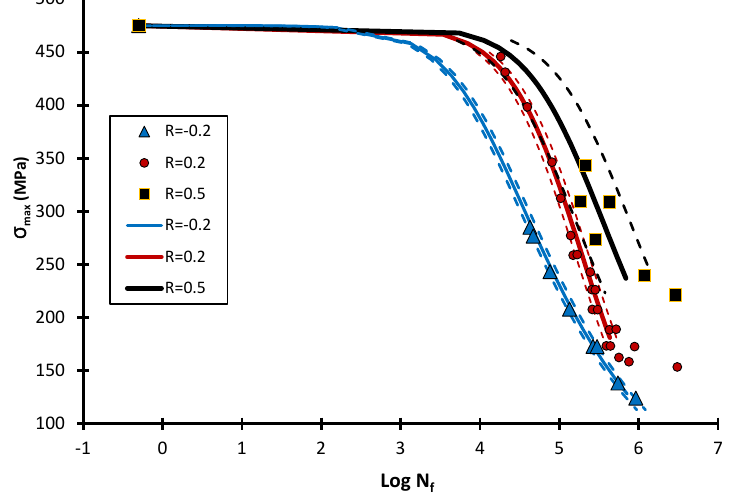
Figure 2. Experimental fatigue data and Kim and Zhang S-N curved model fitted. Table 2. Loading schemes and RFL experimental results ( Δ N 2 ) with prediction errors.